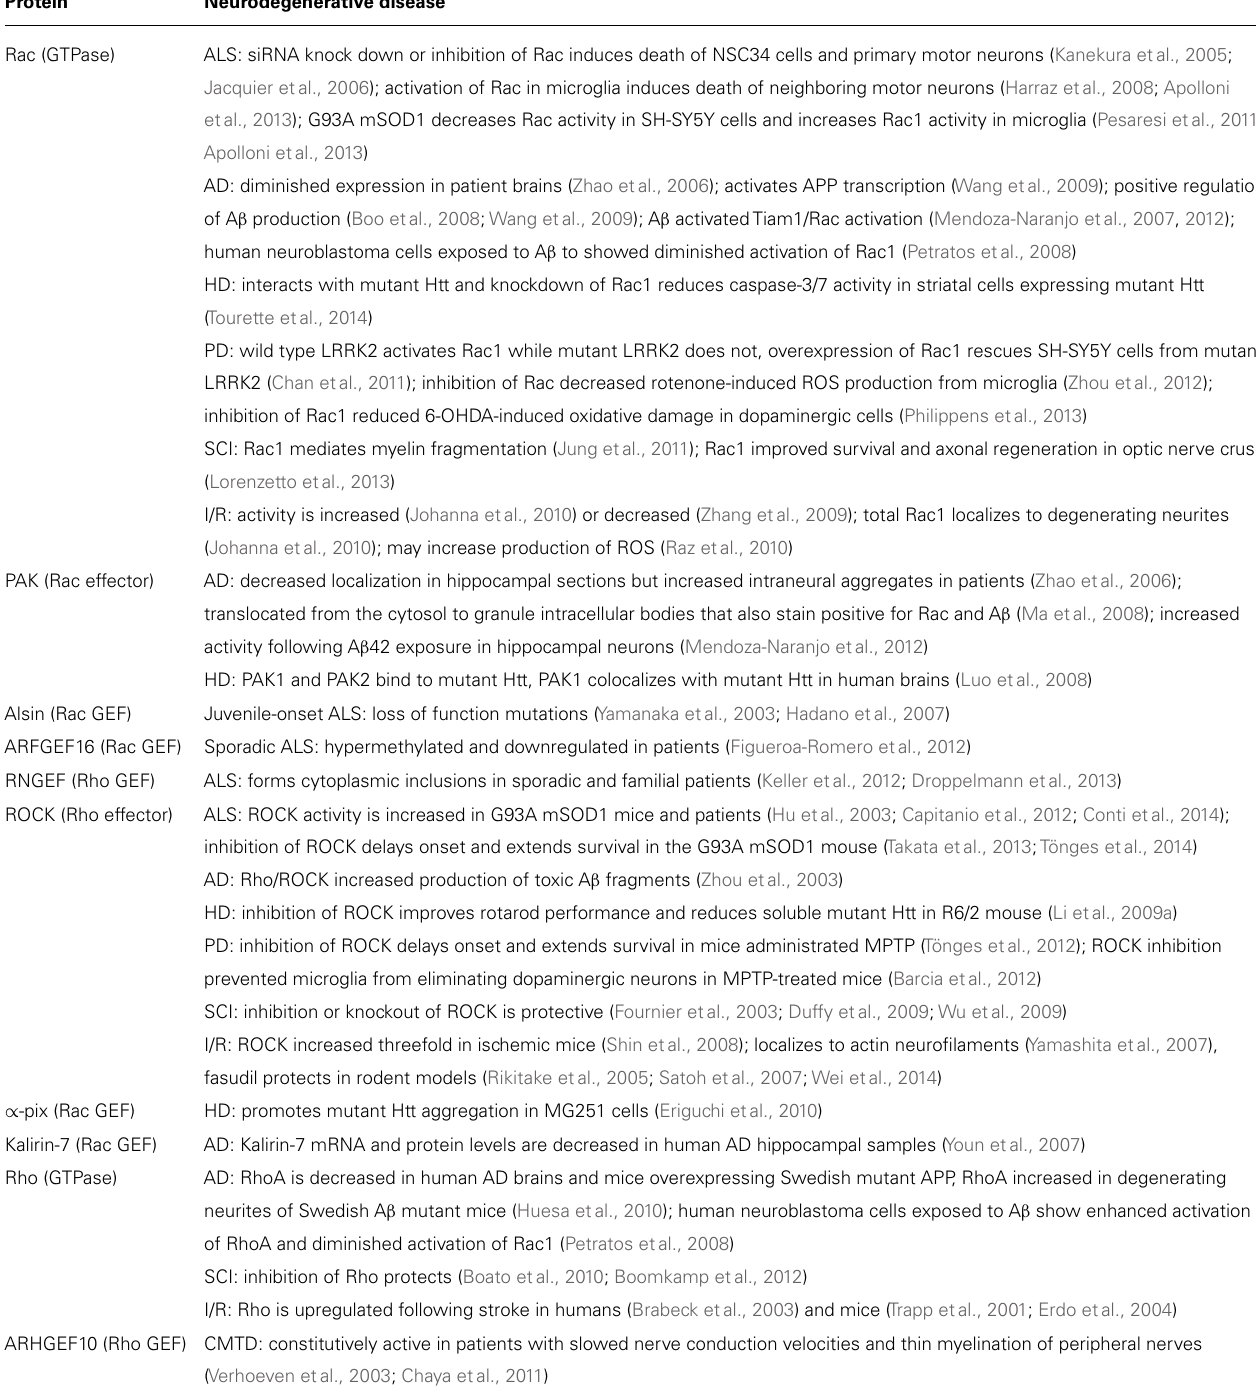
Table 1 | Dysregulated Rho family GTPase signaling in neurodegenerative disease. Protein Neurodegenerative